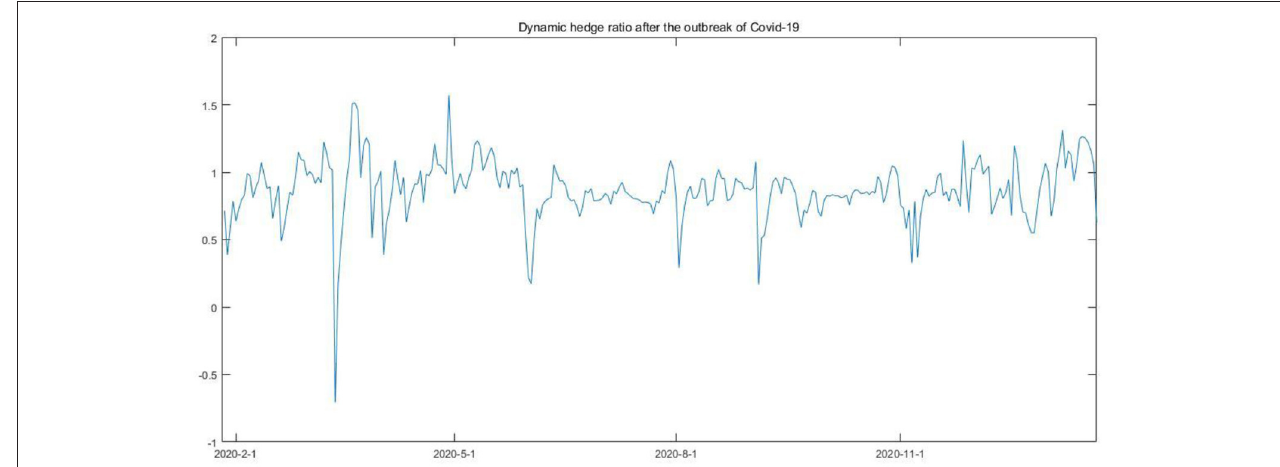
FIGURE 6 | Dynamic hedge ratio after the outbreak of